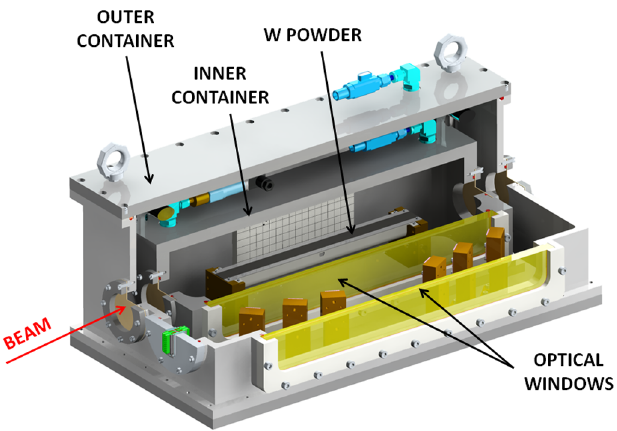
FIG. 1. Section drawing of tungsten powder experiment